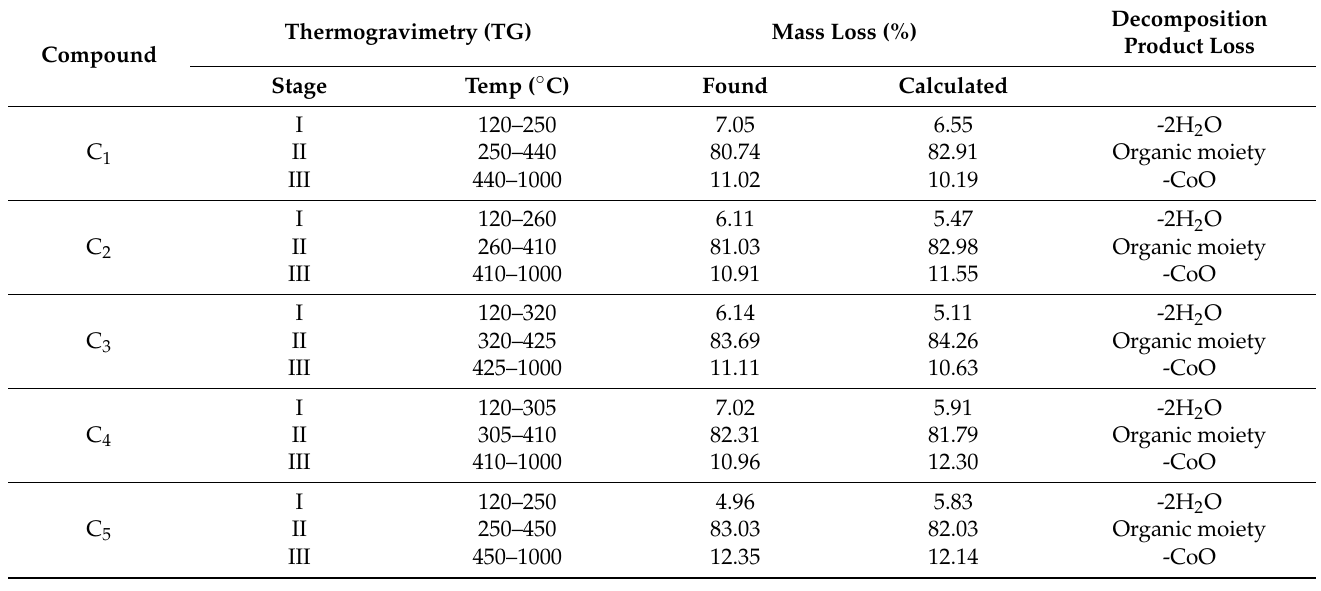
Table 4. Stepwise thermal decomposition of Co(II) metal complexes.